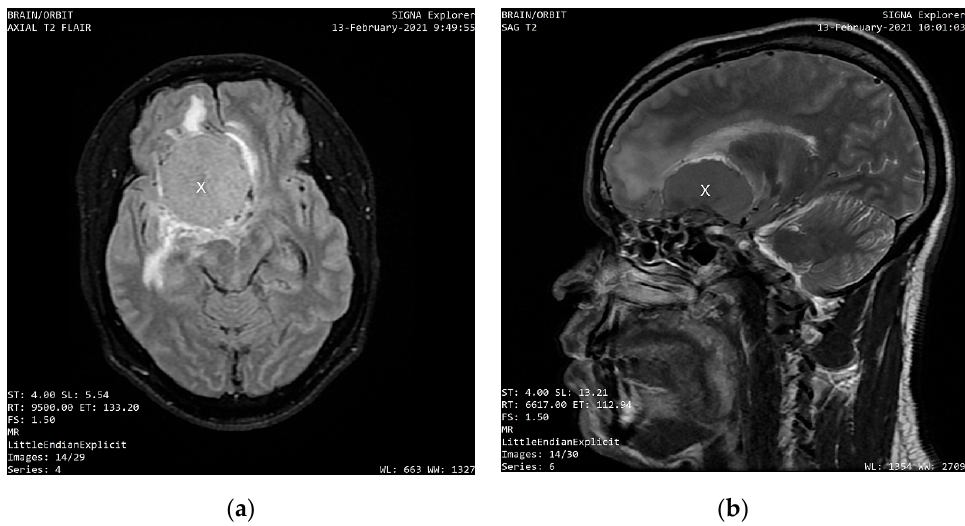
Figure 1. ( a ) An axial section T2 weighted scan showing a well-circumscribed, homogenous mass compressing the right frontal lobe and displacing the falx and the left frontal lobe; ( b ) A sagittal section of the head of the same patient showing the compressive mass.